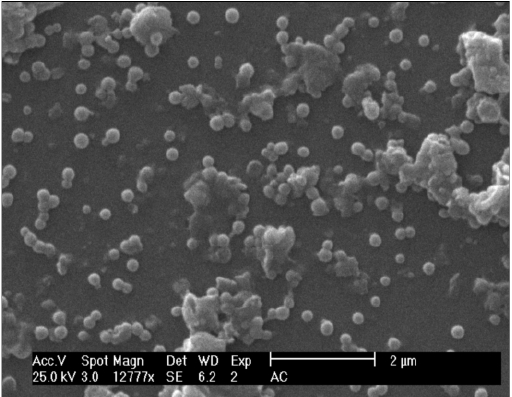
Fig. 1. SEM image of Fe 3 O 4 -activated carbon (AC)